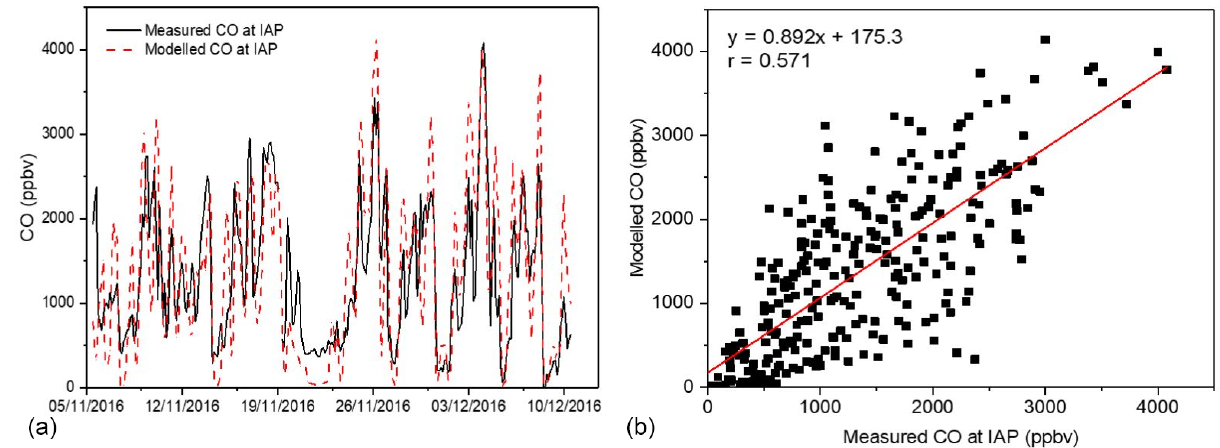
Figure 7. Time series of modelled CO vs. measured CO at IAP during the APHH measurement campaign period (a) , and correlation of measured and modelled CO (b)